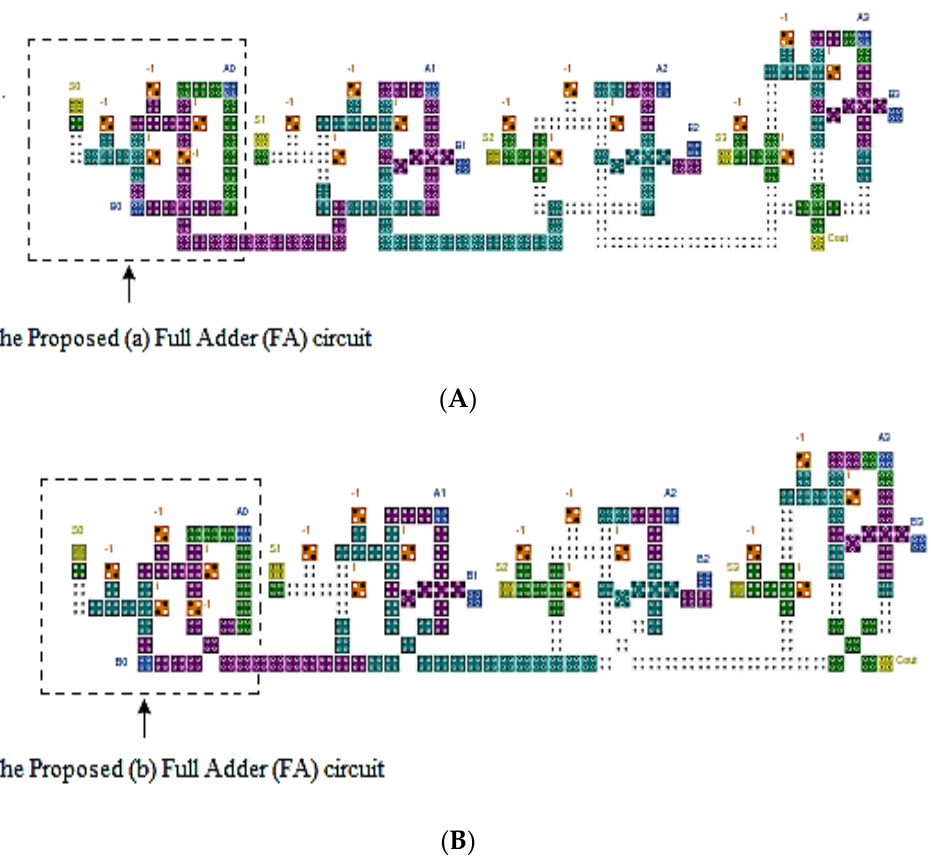
Figure 8. The proposed ( A , B ) 4-bit RCA circuits.